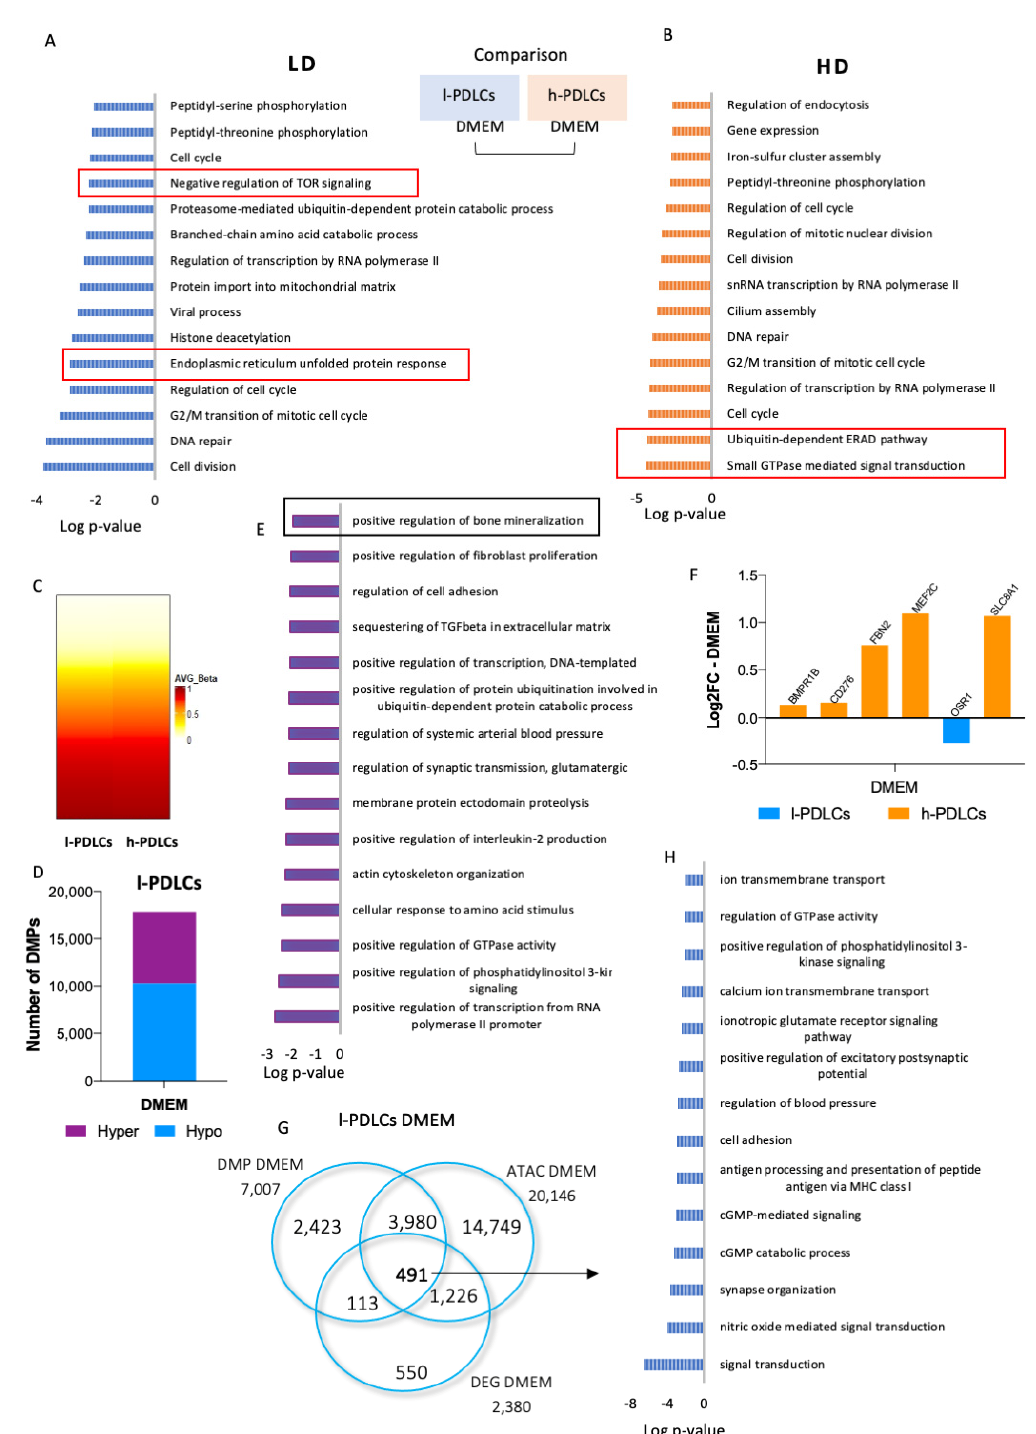
Figure 3. Epigenetic regulation in unstimulated PDLCs with distinct osteogenic potential. l- and h-PDLCs were cultured for 10 days in DMEM for (hydroxy)methylation and chromatin accessibility analyses. ( A , B ) ATAC-seq-identified open chromatin regions were linked to a closest gene and gene lists were analysed for pathway enrichment. The analysis was performed using GO Biological Processes in l-PDLCs (LD) ( A ) and h-PDLCs (HD) ( B ). ( C ) DNA methylation was assessed by Infinium Methylation EPIC BeadChip (Illumina). The heatmap shows the resulting methylation Beta values for 850,000 CpG sites in l- and h-PDLCs. The data for hydroxymethylated probes are shown in Supplementary Figure S2A. ( D ) Methylation status (hypomethylation vs. hypermethylation)